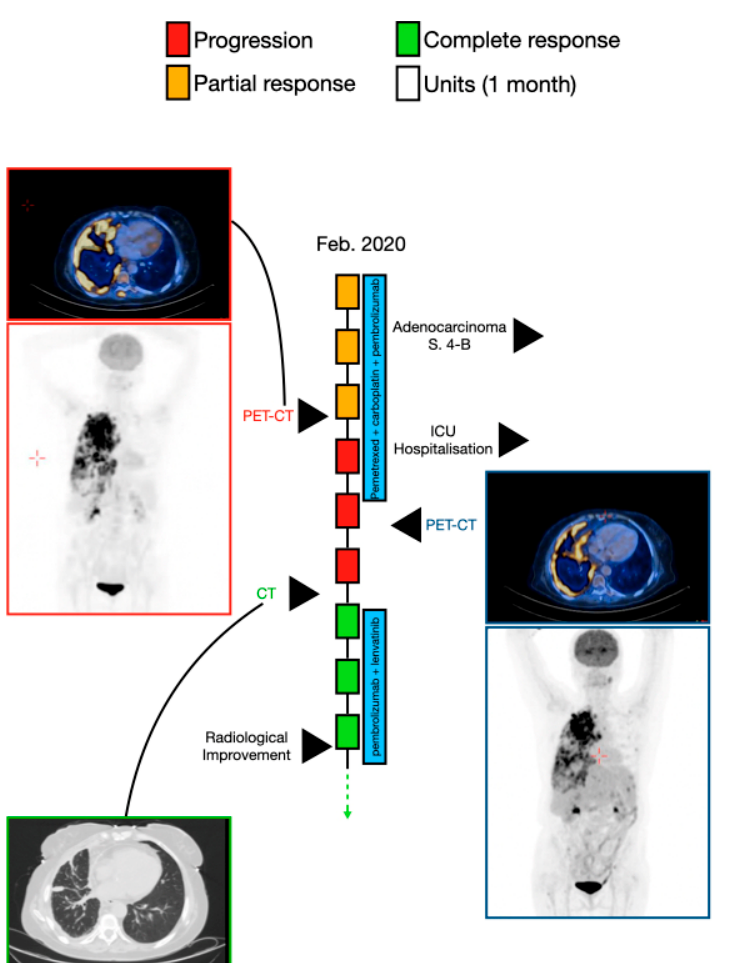
Figure 3. A schematic illustration of patient 3 ′ s timeline, between February 2020 (diagnosis of the disease) and November 2020, including the course of treatment and radiological follow ‐ up. Each rectangle represents 1 month, and the response to treatment during each month is color ‐ coded in green, red, or yellow, as described in the upper legend. Treatment administered in each timepoint is indicated by the blue rectangles. Radiological findings and additional landmarks are presented at relevant points throughout the timeline.